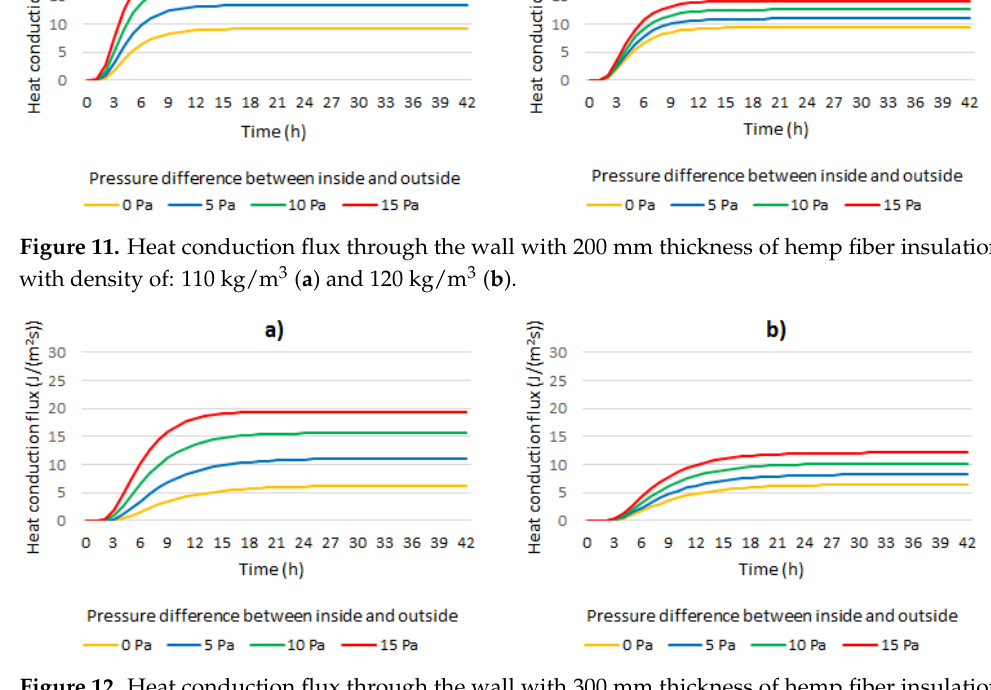
Figure 12. Heat conduction flux through the wall with 300 mm thickness of hemp fiber insulation with density of: 110 kg/m 3 ( a ) and 120 kg/m 3 ( b